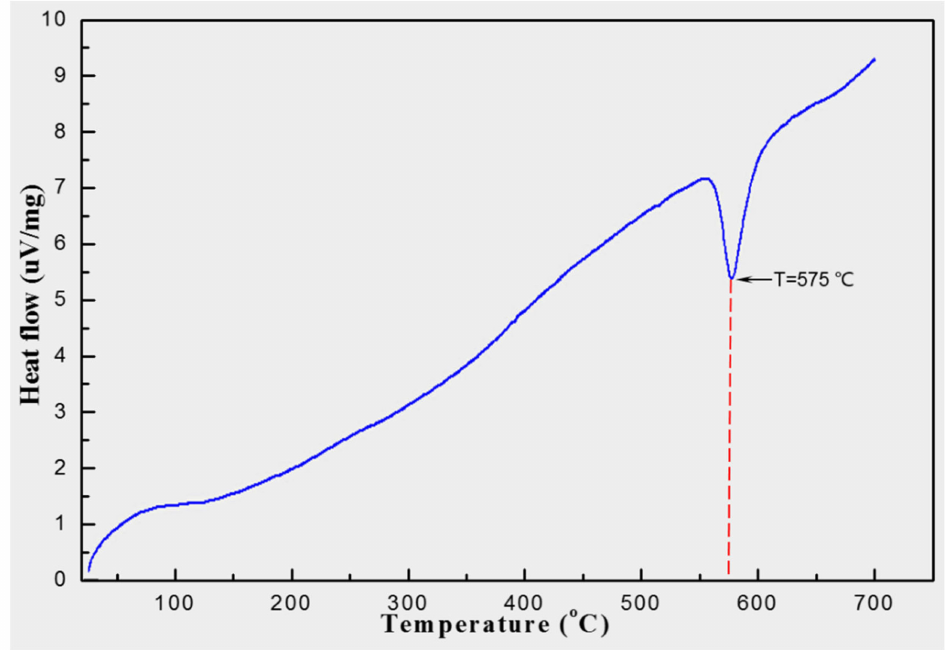
Figure 1. Di ff erential scanning calorimetry (DSC) curve of mixed